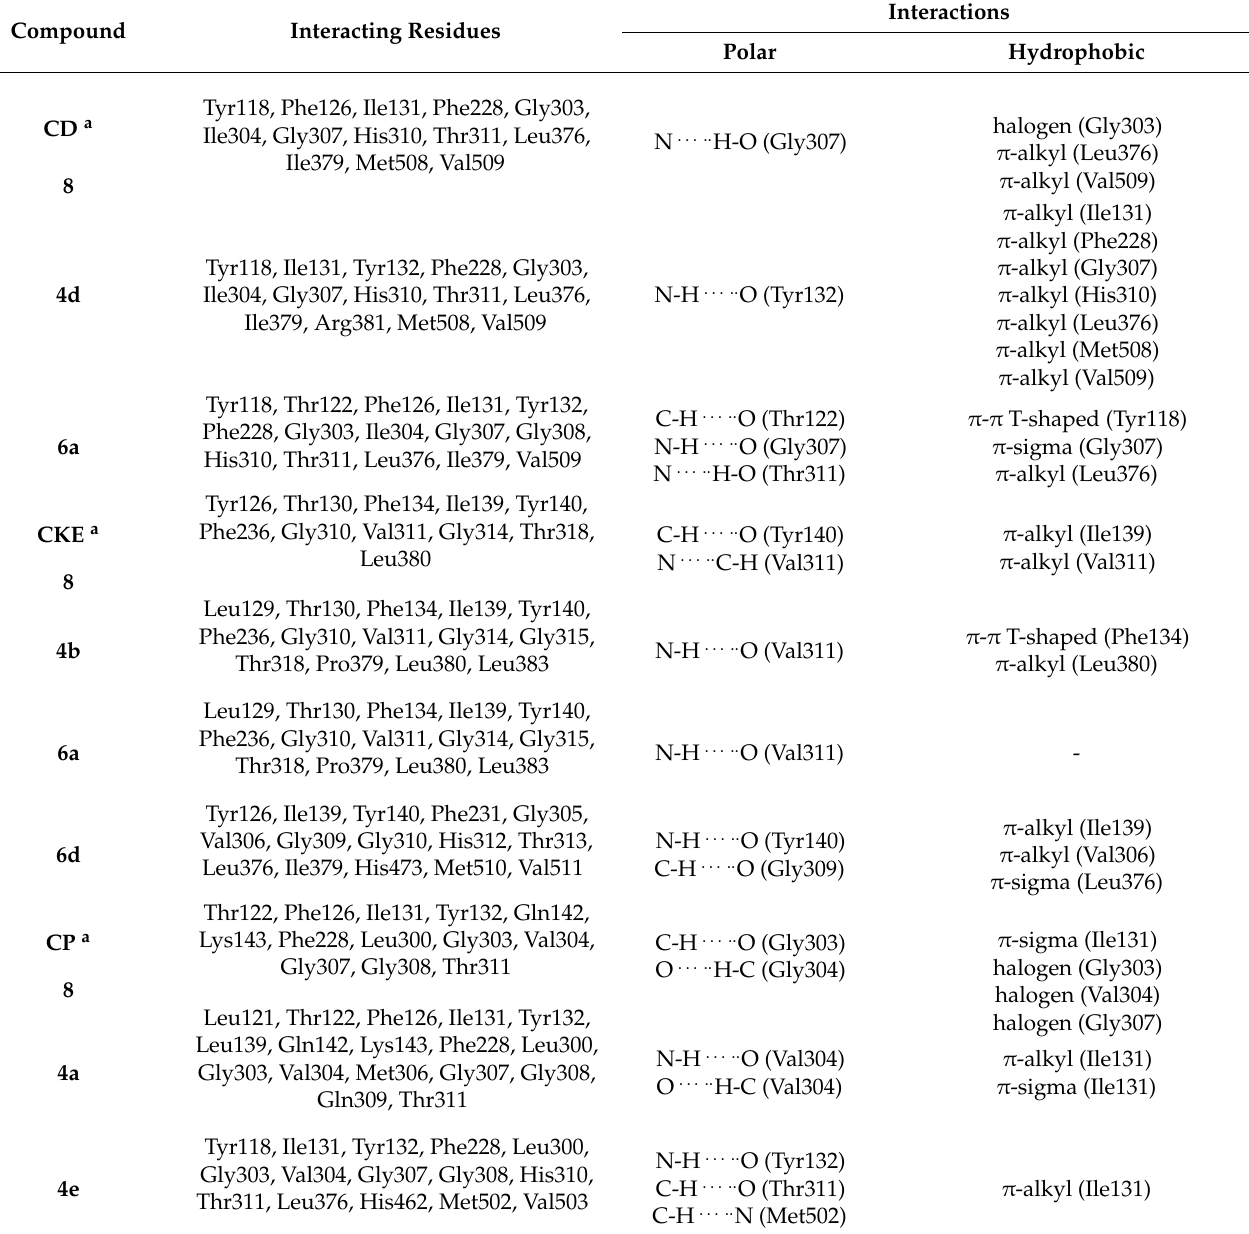
Table 5. Of the two series, the compounds with the best binding energy were chosen, along with 8 to analyze their main interactions with CYP51 enzymes of Candida